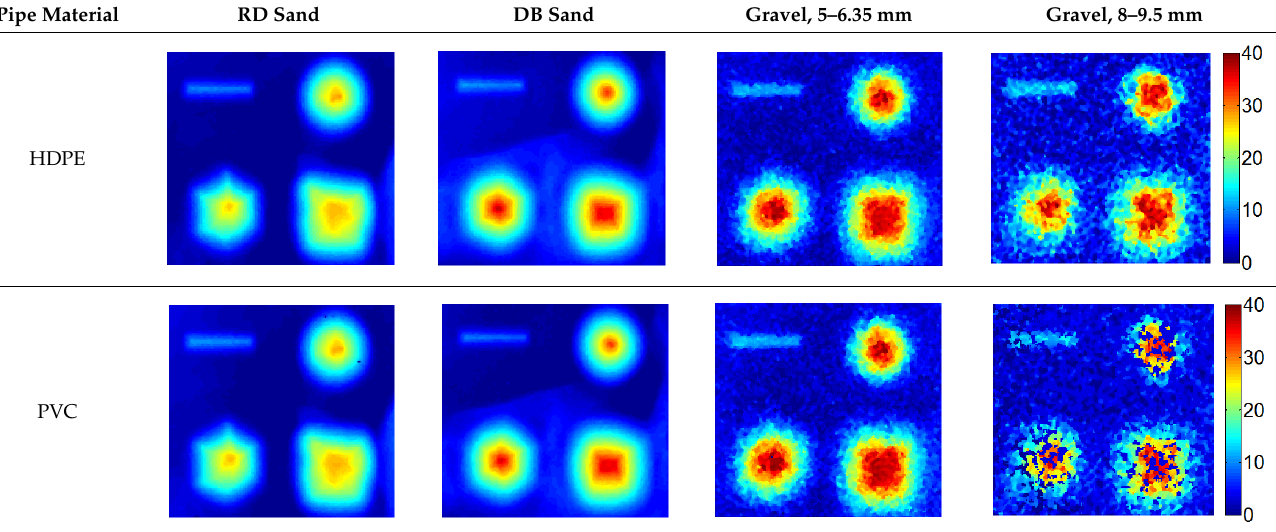
Table 4. Top view of detected voids expressed by depth difference between pipe back surface and the soil surface using 5 MHz ultrasound transducer.